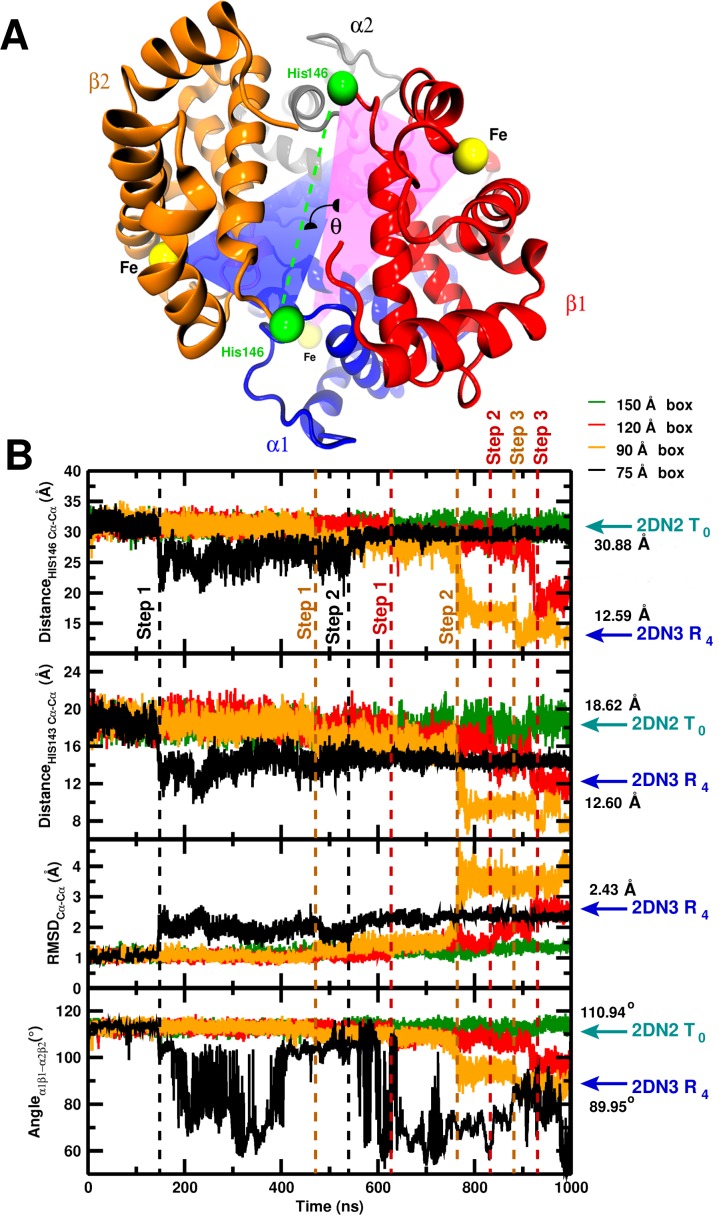
Global structural changes depending on box size.Panel A: Overall structure of the α1β1α2β2 hemoglobin tetramer. The iron atoms (Fe, yellow spheres) and His146 side chains (green spheres) are specifically indicated. The angle θ measures the angle between the two planes containing His146β1Feβ1Feα1 and His146β2Feβ2Feα2, respectively. Panel B: temporal change of (from top to bottom) the Cα–Cα distance between His146β1 and His146β2, the Cα–Cα distance between His143β1 and His143β2, Cα RMSD relative to the 2DN2 X-ray structure, and the angle θ. The dashed lines (black, orange, red) indicate transition points for the 75, 90, and 120 Å boxes, respectively. Cyan and blue arrows indicate the values of the corresponding observables found for the deoxy T0 (2DN2) and oxy R4 (2DN3) states, respectively. Top panel is also given in the main MS.